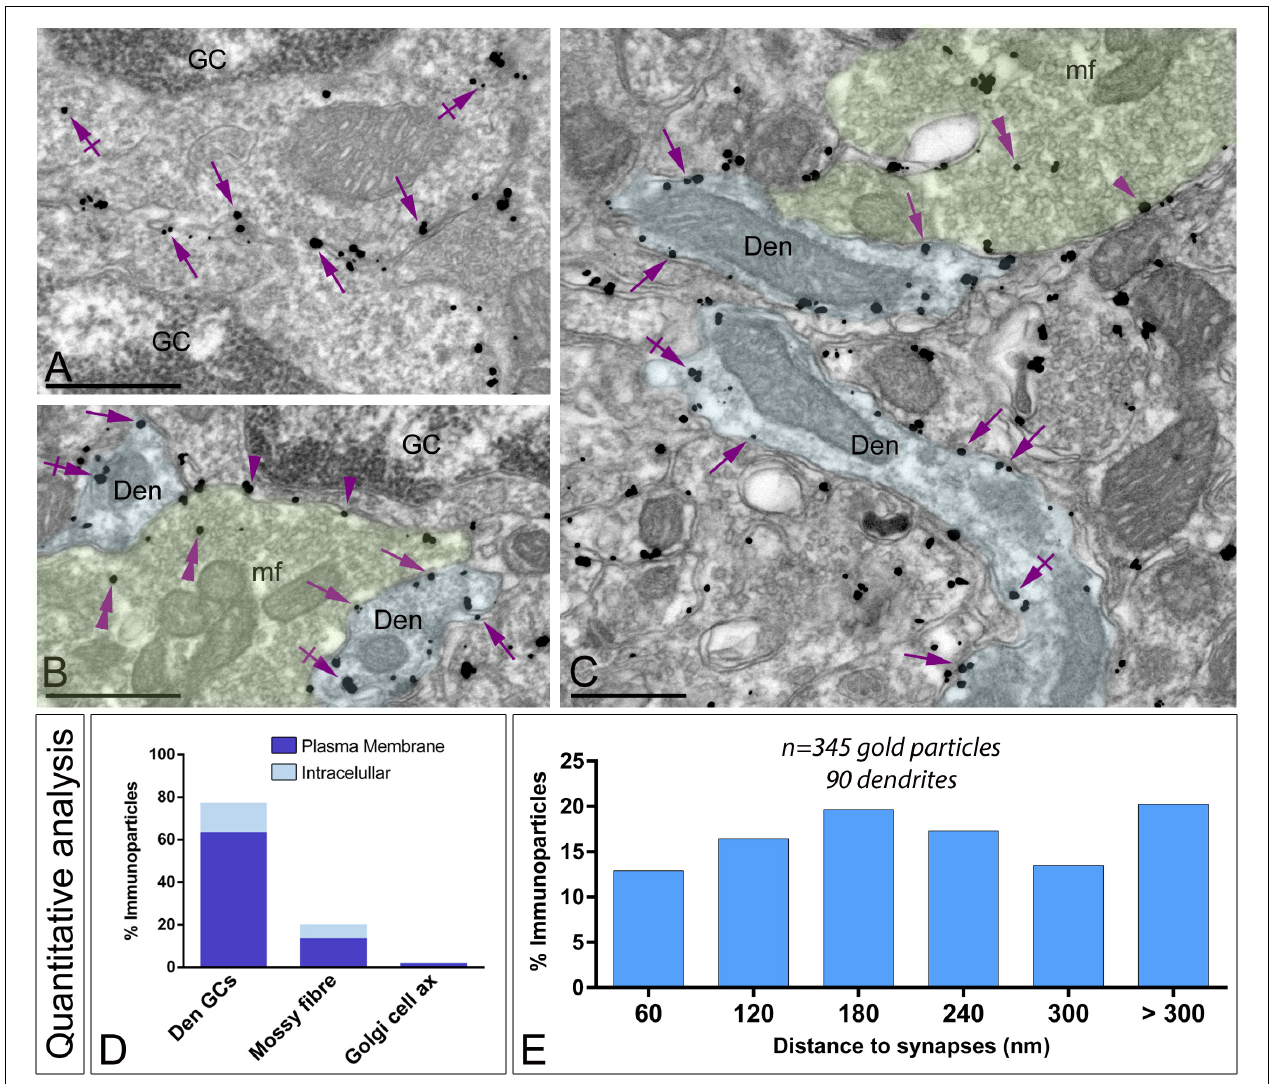
FIGURE 8 | Subcellular localization of G α o in the granule cell layer. Electron micrographs showing immunoparticles for G α o in different neuronal elements present in the granule cell layer of the cerebellum, as detected using a pre-embedding immunogold technique. (A–C) Immunoparticles for G α o were found along the somatic plasma membrane (arrows) and intracellular sites (crossed arrows) of granule cells (GC). Outside granule cell somata, G α o immunoparticles were detected in glomeruli, mainly distributed in the plasma membrane (arrows) and intracellularly (crossed arrows) in granule cell dendrites (Den, blue transparent overlay), as well as presynaptically in mossy fibre terminals (mf, green transparent overlay) in the plasma membrane (arrowheads) and intracellularly (double arrowheads). Scale bars: (A–C) , 500 nm. (D) Histogram showing the percentage of immunoparticles for G α o in glomeruli. A total of 2,194 immunoparticles were analyzed, of which 77.53% were detected in GC dendrites (Den GCs), 20.10% in mossy fiber terminals and only 2.37% in axons of Golgi cells, being mainly distributed along the plasma membrane. (E) Histogram showing the proportion of immunoparticles for G α o ( n = 346 immunoparticles on 90 dendrites) relative to the release of glutamate GC dendrites-mossy fiber synapses. The data shows that 80% of G α o were distributed in a 60–300 nm wide band, indicating its proximity to mossy fiber synapses.